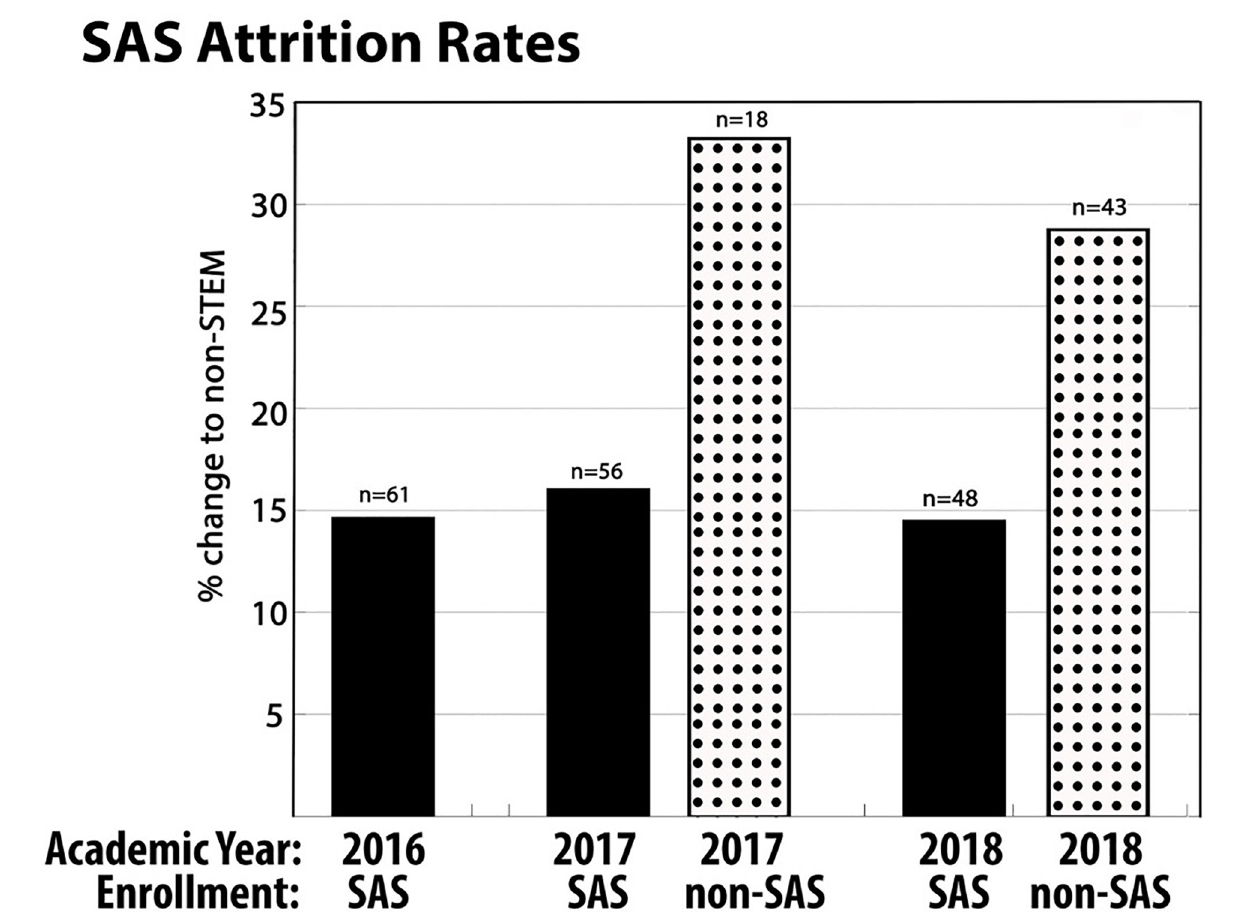
FIGURE 4 | Retention of SAS and non-SAS students in STEM disciplines in 2016, 2017, and 2018. There are no data for non-SAS students in 2016 due to limited sample size. These data represent attrition rates for first-year biology students at Pepperdine University. These data were scored by declared major at the conclusion of the third semester of enrollment. All students assessed entered Pepperdine as biology